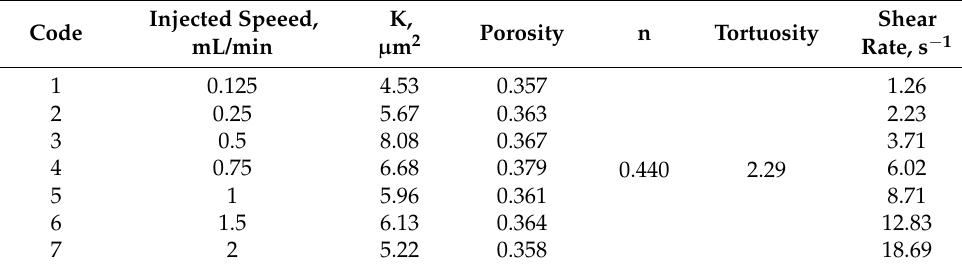
Table 2. Gelation times of dynamic gelation in porous media under different injection speeds. Injected Speeed, Code mL/min